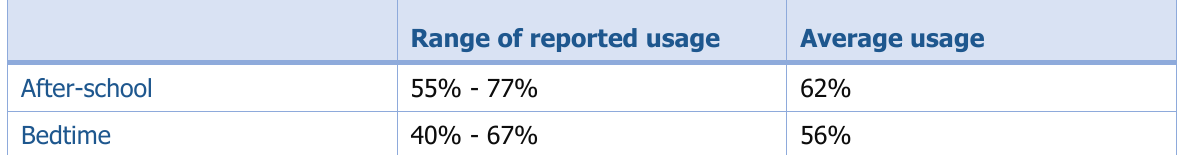
Table 7. Times Youth Most Frequently Cited for Electronics